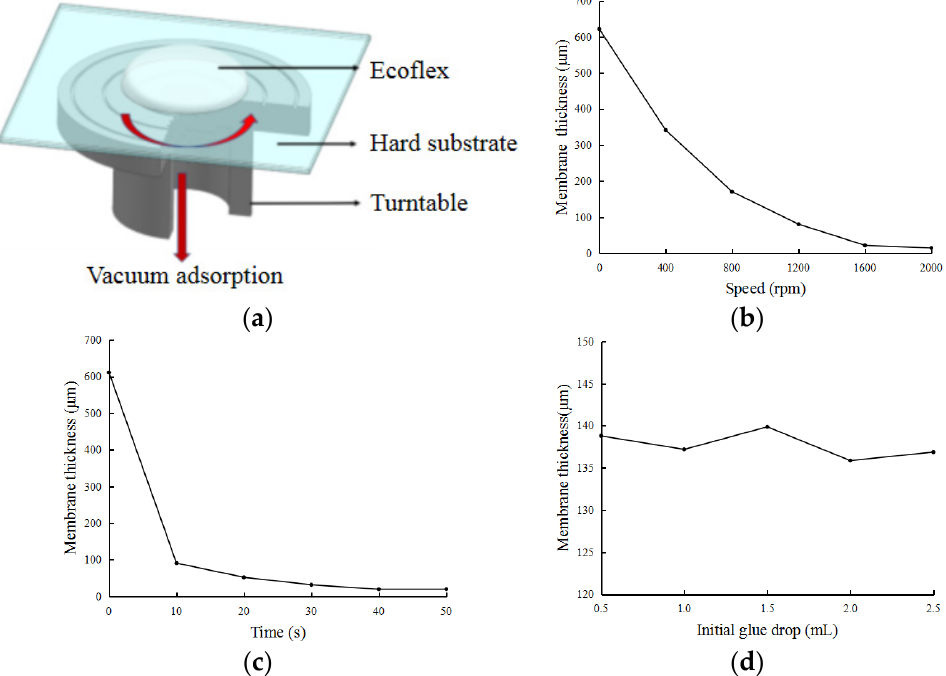
Figure 4. Spin Coating Flexible Substrates. ( a ) Schematic diagram of spin coating; ( b ) relationship between film thickness and spin coating speed; ( c ) relationship between film thickness and spin coating time; ( d ) relationship between film thickness and spin coating time initial glue drop.